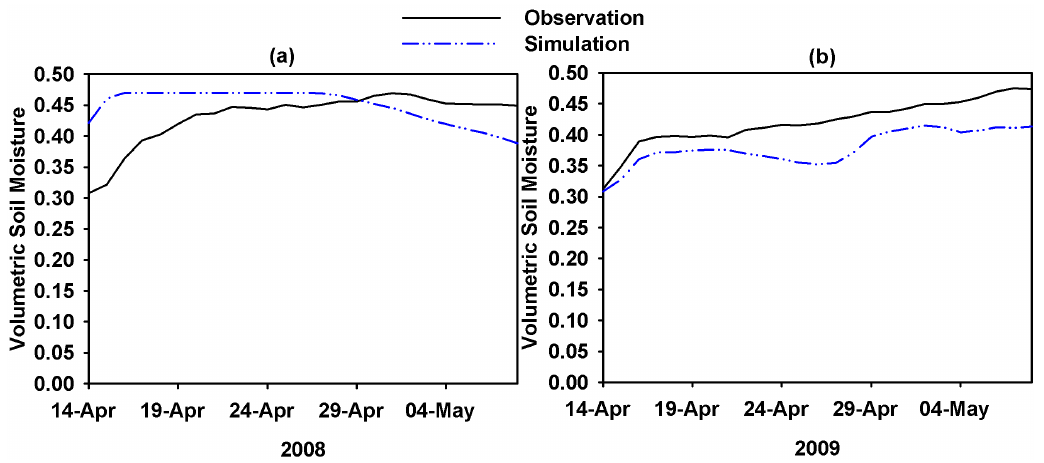
Fig. 9. Comparisons of the observed and simulated volumetric spring soil moisture from the main weather station in the Smith Creek Research Basin. (a) 2008 simulation period and (b) 2009 simulation